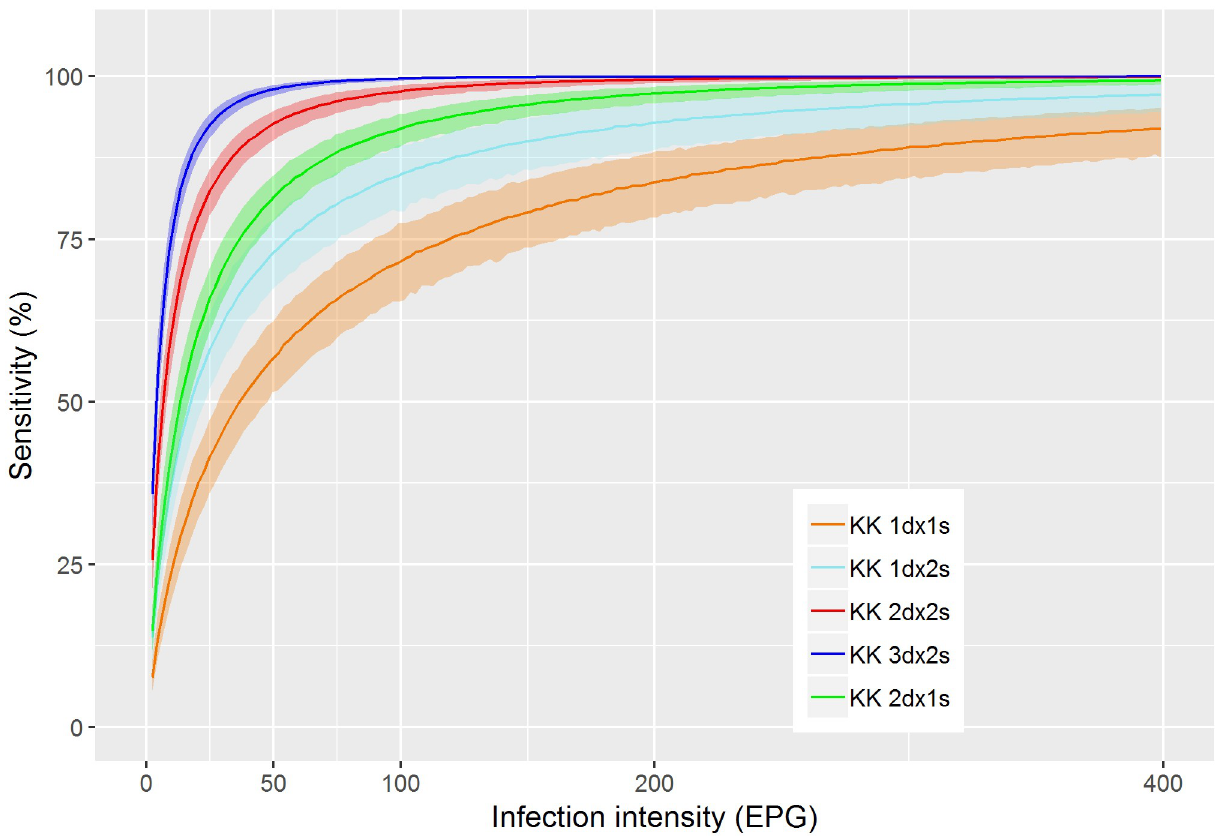
Fig 2. Model-based estimates of the infection intensity-dependent sensitivity of Kato-Katz for various numbers of days ( d ) with one or two samples ( s ).